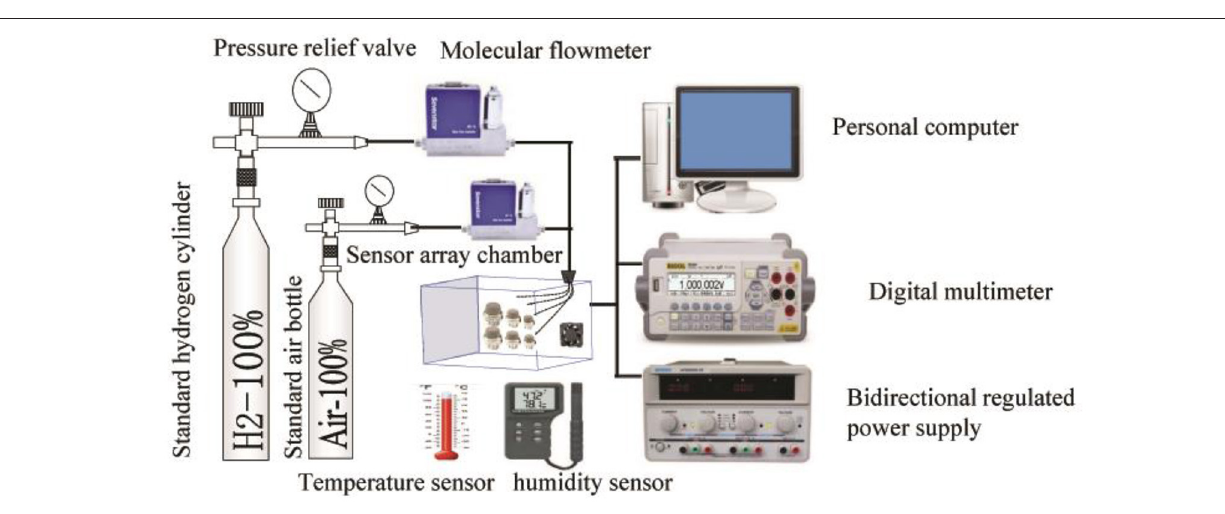
FIGURE 4 | A system diagram of hydrogen sensor